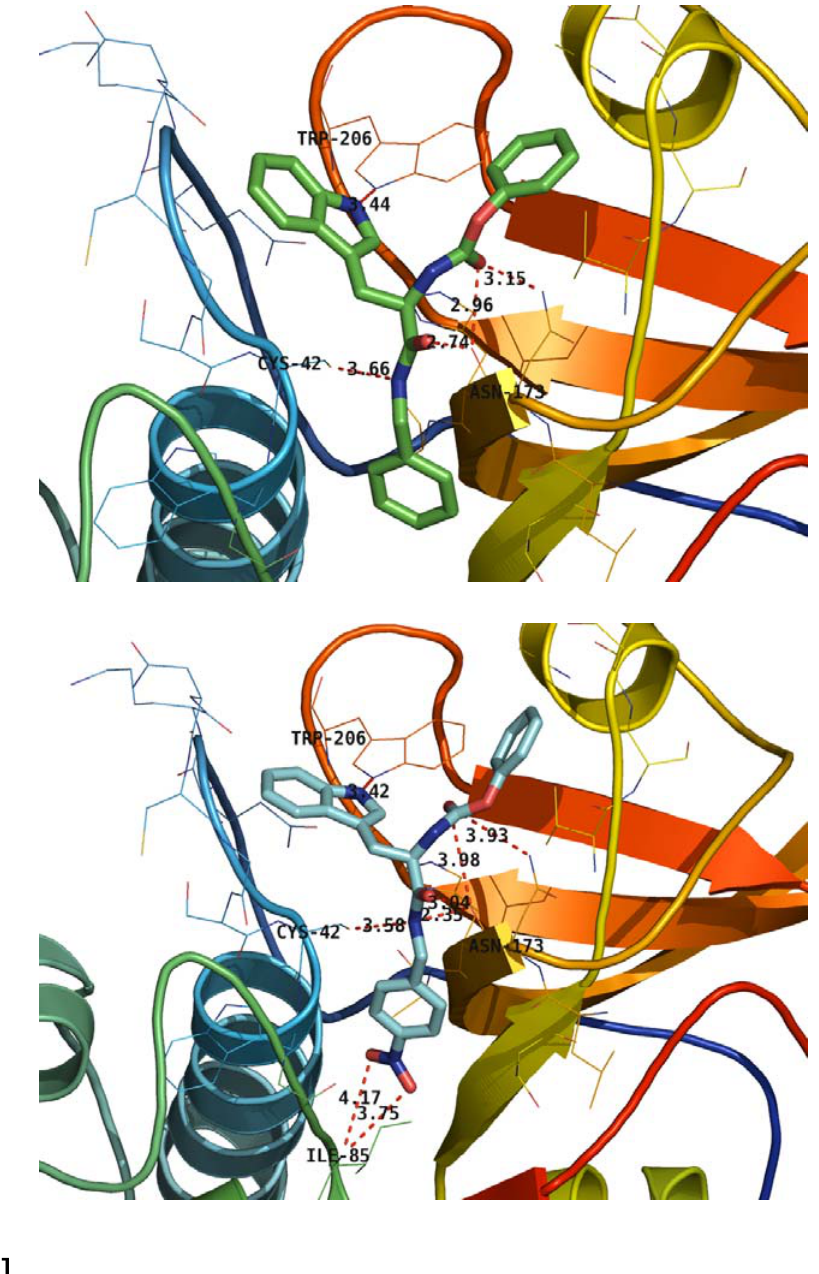
Figure 4. Detailed interactions of 1 (A) and 2k (B) to the binding sites of FP-2. Compounds 1 and 2k are indicated by cyan and green thick sticks, respectively, and hydrogen atoms have been omitted for clarity. Key residues of the binding pocket are shown as lines. Hydrogen bonds are shown as red dotted lines with the distance between donor and acceptor atoms. The structure figures were using PyMol